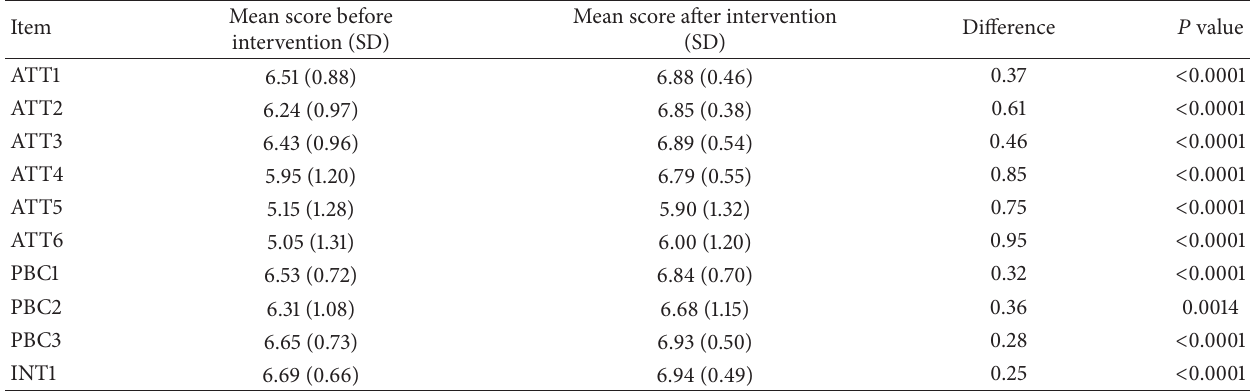
Table 3: Differences between pre- and postintervention scores on survey items 1 .